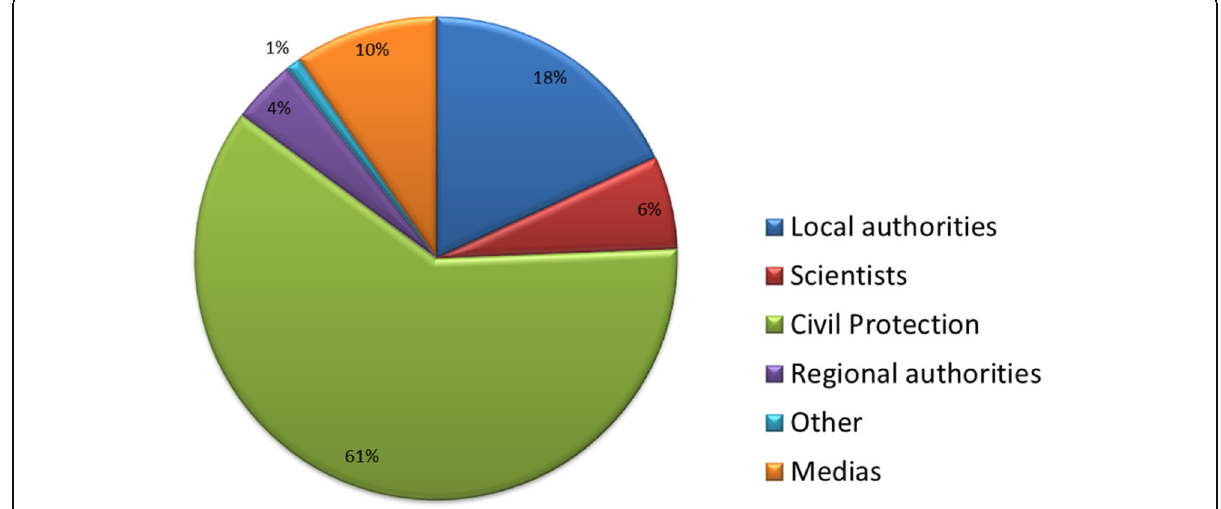
Fig. 4 Answer to the question: “ Which authority do you trust in for the information on the lahars you receive? ” ( N =